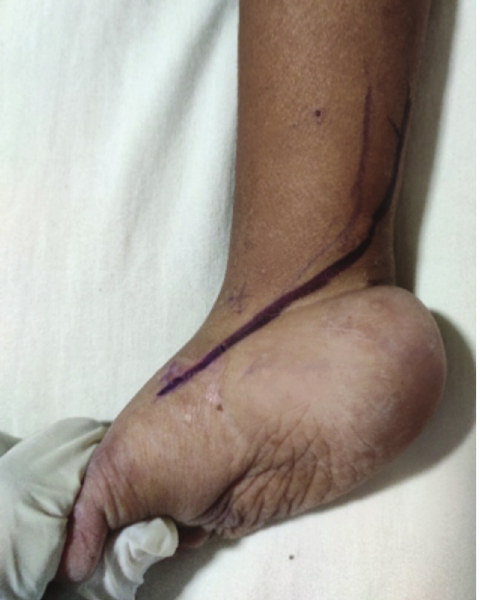
Incision on the foot extending from base of Fig. 1: 1st metatarsal to tendoachilles proximally and posteriorly. The scar is divided into two components – horizontal and vertical according to their orientation.